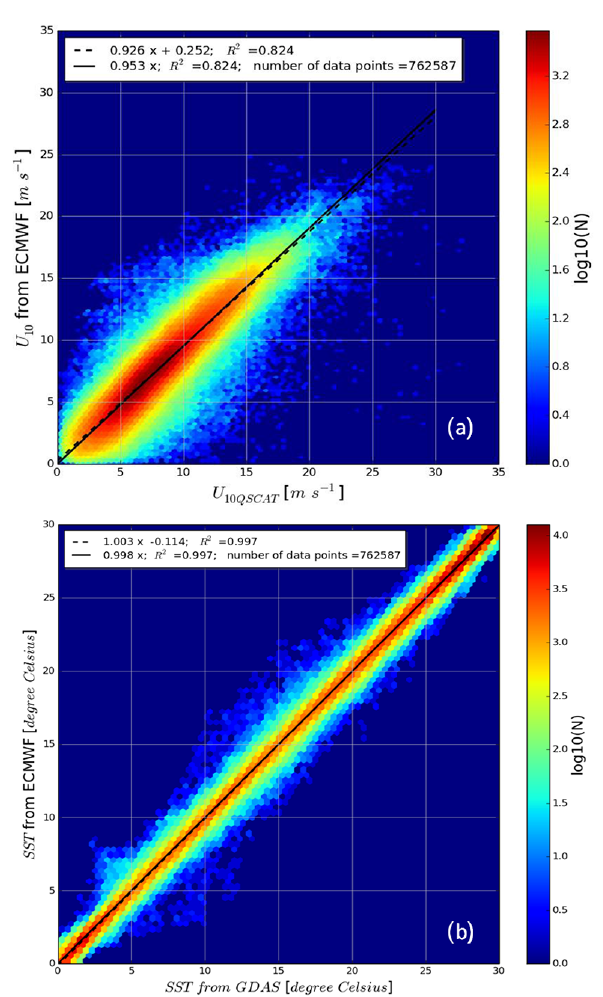
Figure 4. Scatter plot for March 2006 of (a) global U 10ECMWF vs. U 10QSCAT and (b) global T from ECMWF vs. T from GDAS. In both figures the colors indicate the amount of data points per hexbin. The black lines are linear fits: the dashed line represents unrestricted fit and the solid line a fit forced through zero. The linear regressions and respective R 2 are listed in each